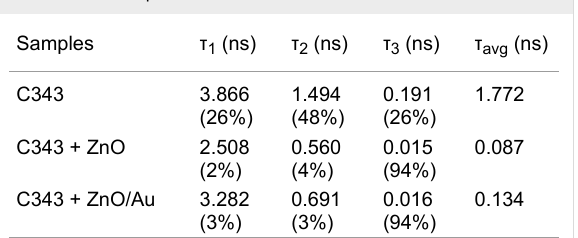
Figure 5: (a) PL spectra and (b) PL transients of the C343 dye observed at 480 nm in the presence and absence of bare ZnO nanorods and ZnO/Au nanocomposites. The IRF was 50 ps (FWHM) and all the samples were excited at a laser wavelength of 409 nm.